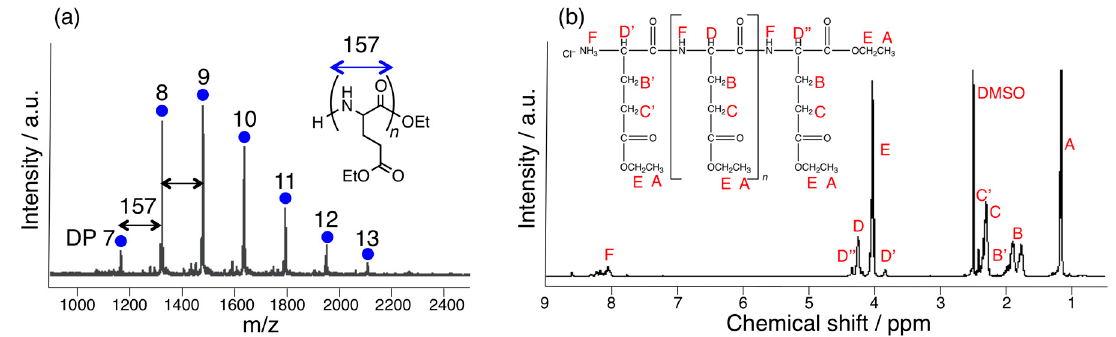
Figure 6. MALDI-TOF MS ( a ) and 1 H-NMR ( b ) spectra of the papain-catalyzed reaction product using Glu(Et) 2 and nylon 1Et as substrates. The MS spectrum was obtained in linear positive mode using HABA and Na-TFA as the matrix and cationic reagent, respectively. 1 H-NMR was measured using DMSO- d 6 as the solvent.